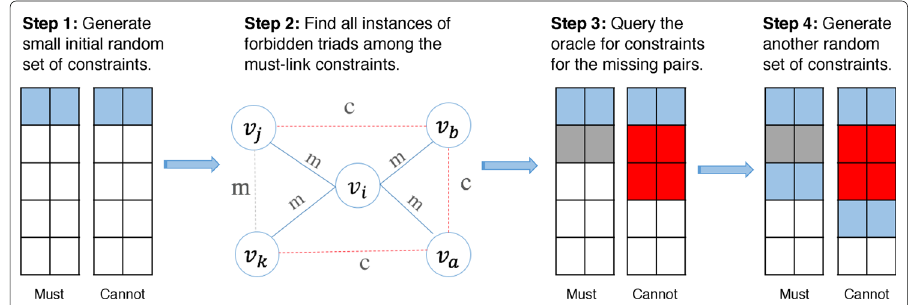
Fig. 2 An illustration of all steps in the overlapping constraint selection process